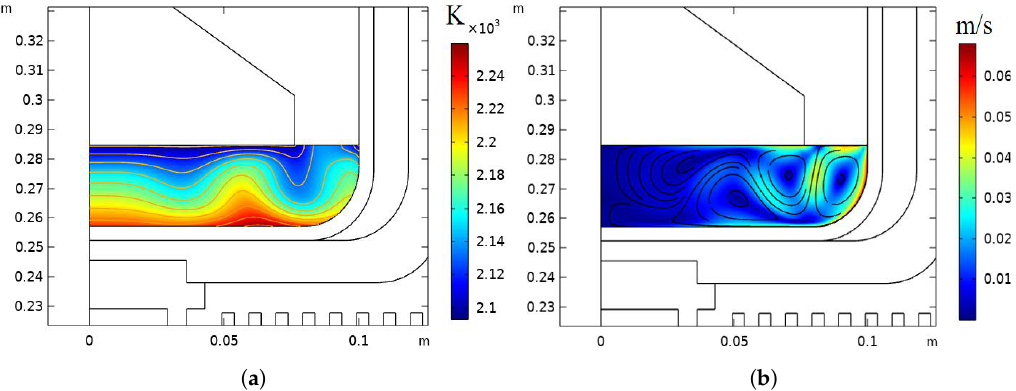
Figure 4. Crucible for six inches with rotation: ( a ) temperature distribution and isotherms; ( b ) streamlines of the veloc- ity field.